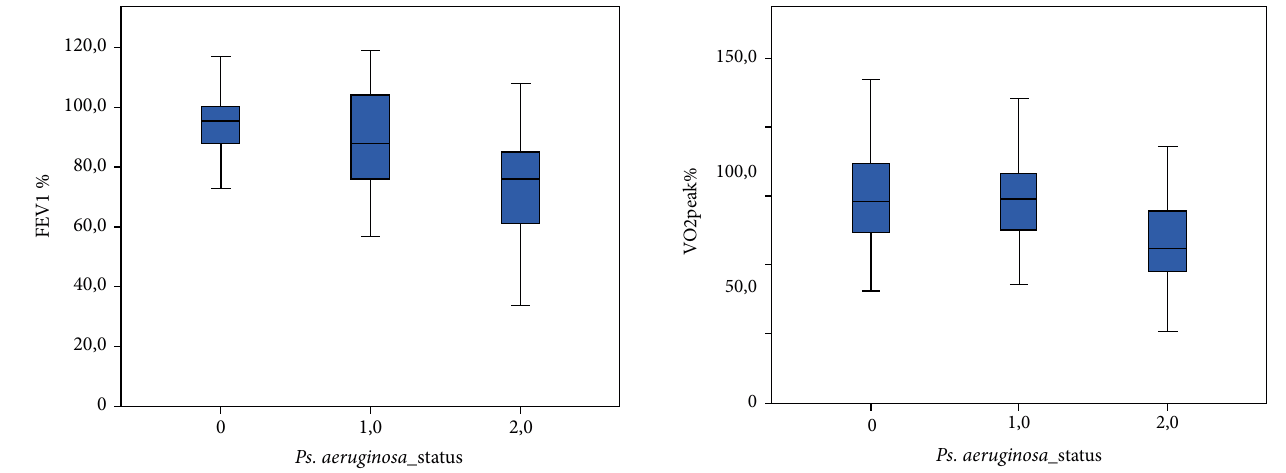
Figure 3: VO peak% predicted among patients not colonized, 2 intermittently and chronically colonized with Pseudomonas aeruginosa . (0: patients not colonized, 1: patients intermittently colonized with P. aeruginosa , 2: patients chronically colonized with P. aeruginosa